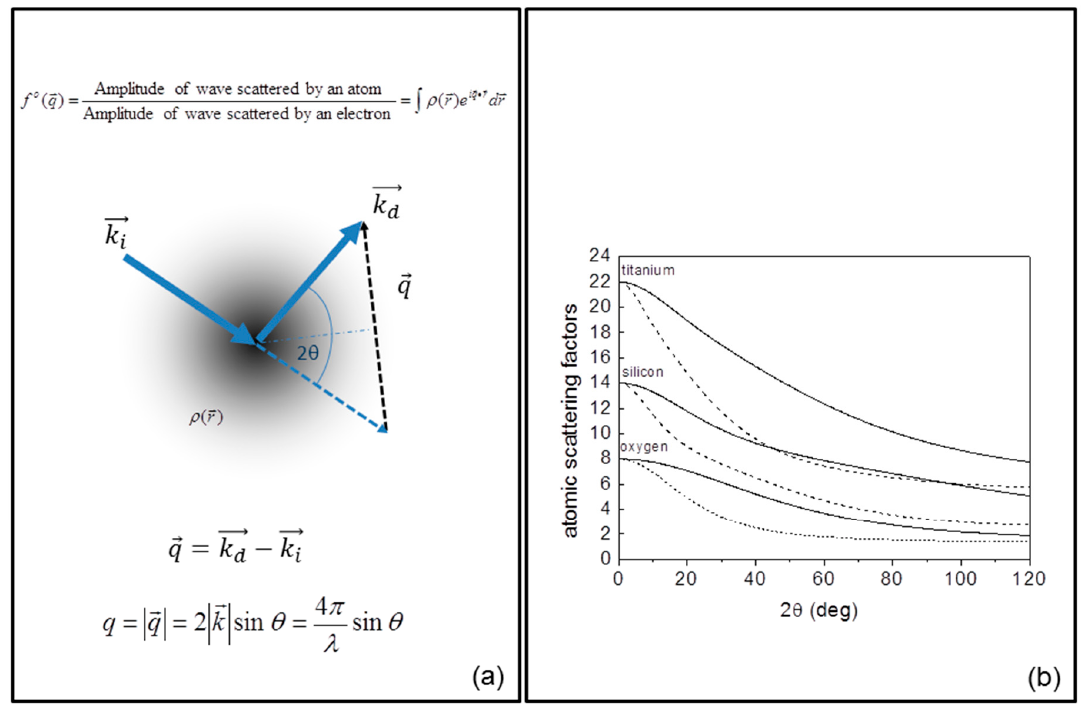
Figure 1. ( a ) On the top is the atomic scattering factor formula, in the center a scattering atom, at the bottom the scattering vector, i.e., the difference between diffracted ( ( b ) atomic scattering factors for oxygen (Z = 8), silicon (Z = 14) and titanium (Z = 22), evaluated for Cu K α 1 , i.e., λ = 1.540562 Å (full lines), and for Mo K α 1 , i.e., λ = 0.71072 Å (dotted